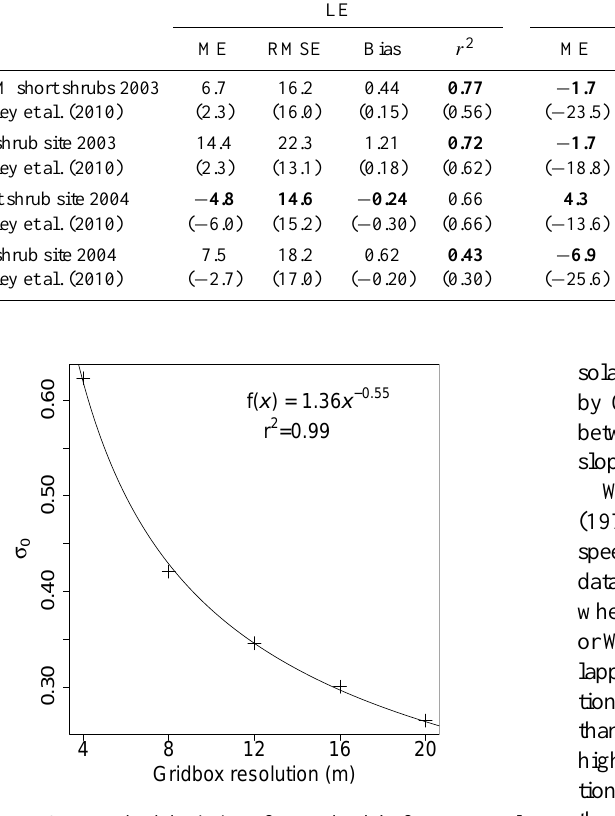
Figure 5. DBSM standard deviation of snow depth before snowmelt as a function of grid-box size. The equation and correlation coeffi- cient of a power function to the relationship is displayed for conve-